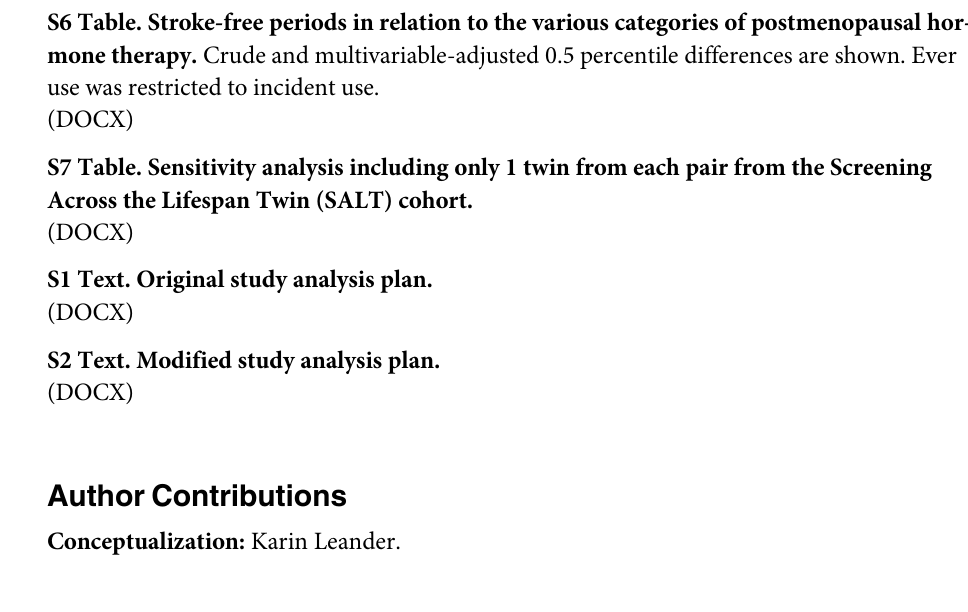
S2 Fig. Survival curves computed using censored quantile regression. S3 Fig. Stroke and haemorrhagic stroke survival curves for route of administration. S1 Table. Number of women in different postmenopausal hormone therapy categories as assessed using the Combined cohorts of menopausal women—Studies of register-based health outcomes in relation to hormonal drugs (COMPREHEND) material. S2 Table. Stroke-free and haemorrhagic stroke-free periods in relation to the type, active ingredient, route of administration, and duration of postmenopausal hormone therapy, without stratification according to timing of initiation. Crude and multivariable-adjusted percentile differences are shown. S3 Table. Stroke-free and haemorrhagic stroke-free periods in relation to the various cate- gories of postmenopausal hormone therapy by timing of initiation. Crude and multivari- able-adjusted percentile differences are shown. S4 Table. Complete case analysis for stroke-free and haemorrhagic stroke-free periods in relation to the various categories of postmenopausal hormone therapy by timing of initia- tion. S5 Table. Sensitivity analysis in which women without detailed information on timing of postmenopausal hormone therapy initiation were allocated to the early initiator groups based on their age at baseline. S6 Table. Stroke-free periods in relation to the various categories of postmenopausal hor- mone therapy. Crude and multivariable-adjusted 0.5 percentile differences are shown. Ever use was restricted to incident use. S7 Table. Sensitivity analysis including only 1 twin from each pair from the Screening Across the Lifespan Twin (SALT)